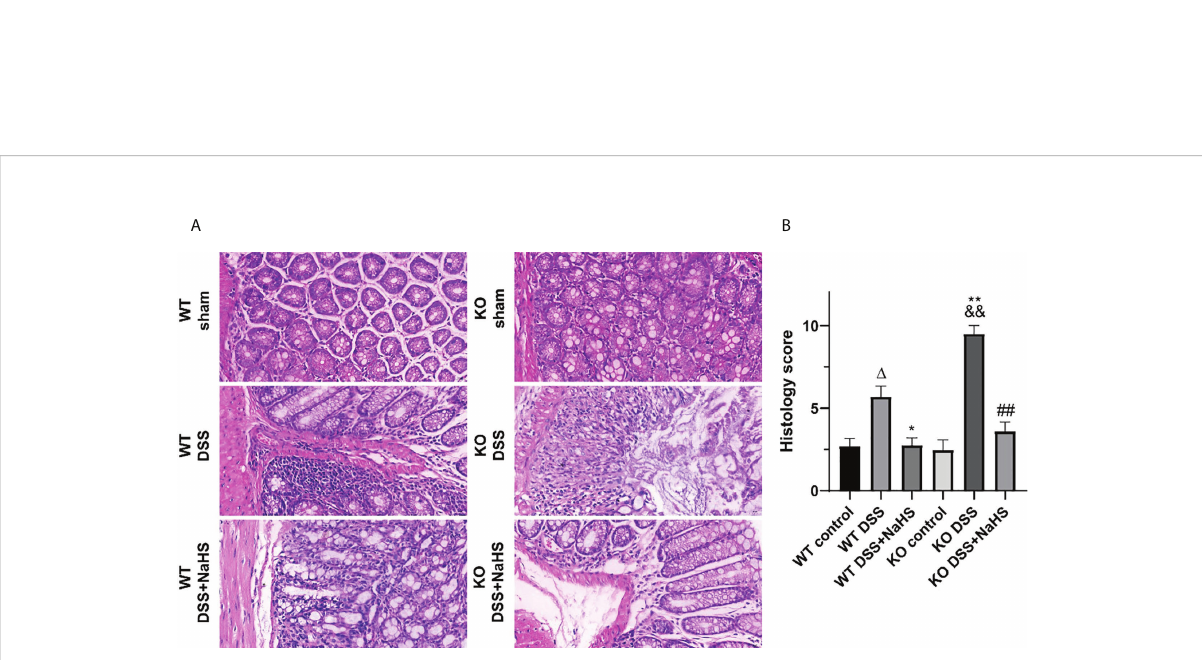
FIGURE 2 Effect of cystathionine- g -lyase (CSE)-derived hydrogen sul fi de (H2S) on colonic injury and histological score (hematoxylin and eosin (H&E) staining). Data are expressed as the mean ± SEM, N=3. Scale bar = 20 m m. (A) Typical histological sections stained with H&E (400×magni fi cation). (B) Histological scores of colon. D P < 0.05 vs wild-type(WT) control group; *P < 0.05, **P < 0.01 vs WT dextran sodium sulfate (DSS) group; && P < 0.01 vs knockout (KO) control group; ## P<0.01 vs KO DSS group